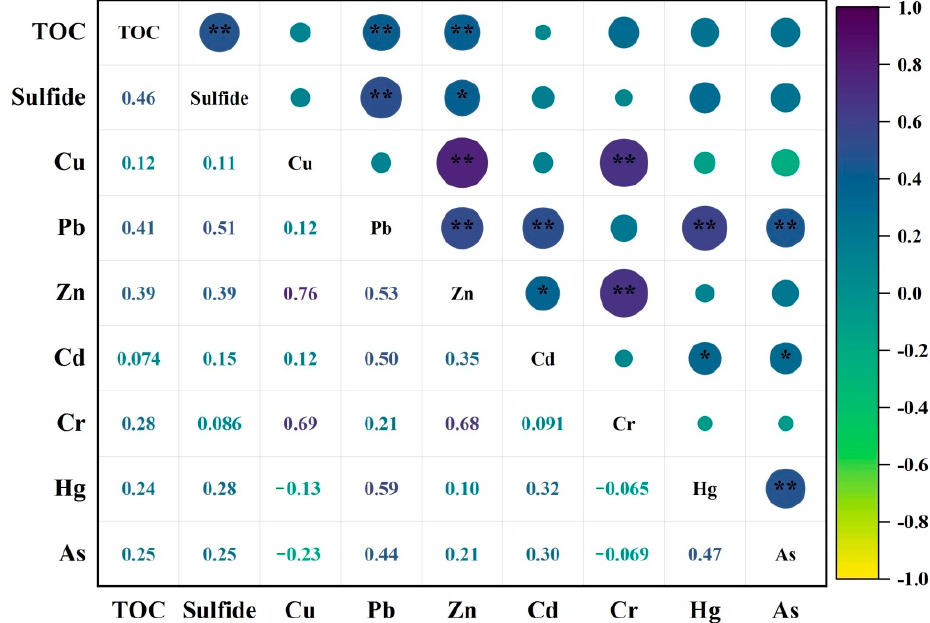
Figure 8. Correlation analysis of PTEs, TOC and sulfide in the surface sediment of Xiamen Bay (* p ≤ 0.05, ** p ≤ 0.01.).